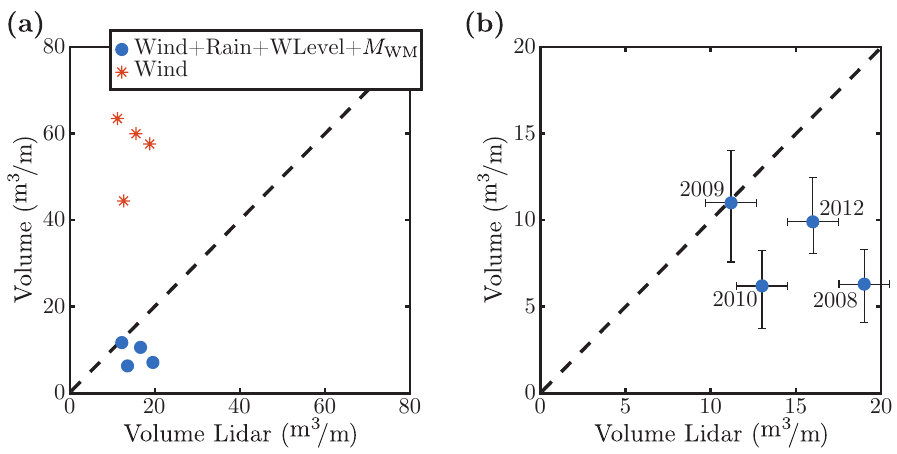
Figure 15. ( a ) Comparison of volume increase (calculated and measured) for years without storm surges, 2008, 2009, 2010 and 2012. The maximum water level during these years was lower than 2.0 m. The blue dots represent the volume calculated according Equation (6), considering hourly average wind speed data and a surface moisture content ( M WM ) equal to 1.2%. The red dots represent the volumes transported during the same years, but the only data considered corresponds to hourly average wind speed, i.e., M = 0%. The dashed line represents a 1 to 1 slope line. ( b ) A zoom-in of the calculations using a moisture content of 1.2%. The error bars represent the volumes obtained for moisture contents of 1.0% and 1.5% and the error related to the LiDAR measurements. Table 6. Amount of hours in which transport or no transport was observed in the images, when U (cid:62) U Threshold considering onshore wind conditions and its relationship with the presence or absence of rain during the same hour. Where U Threshold Onshore = 7 m/s corresponds to the minimum hourly wind speed at which transport was observed in the images. Rain Yes No Transport Yes 84 422 Images No 93